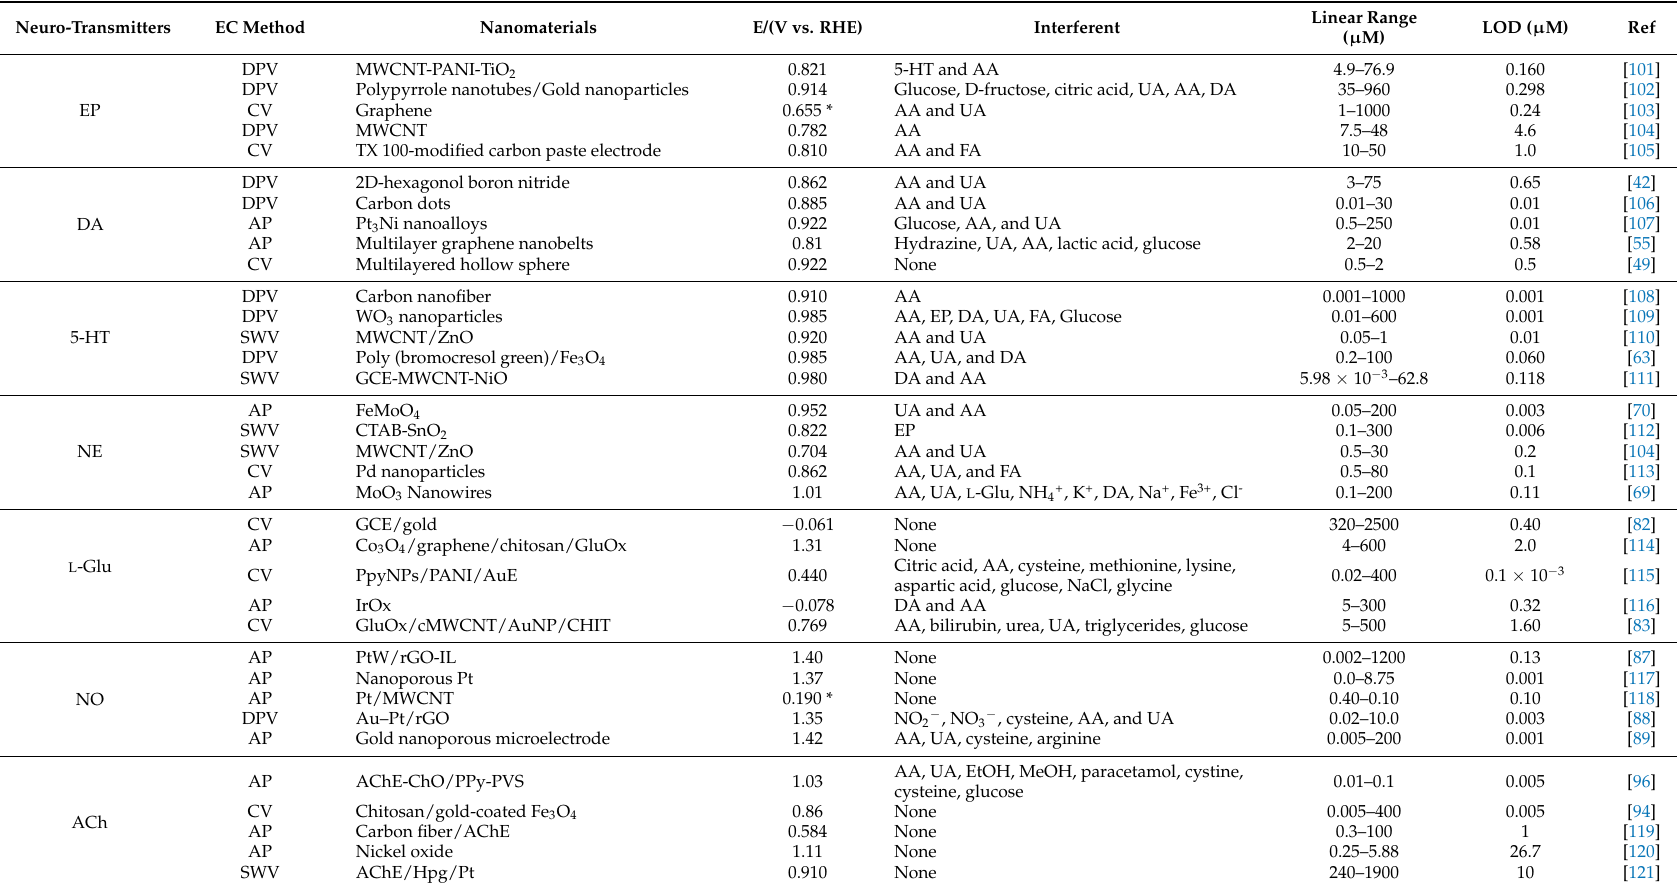
Table 1. A list of nanomaterials-based sensing platforms and their performances in the detection of neurotransmitters.